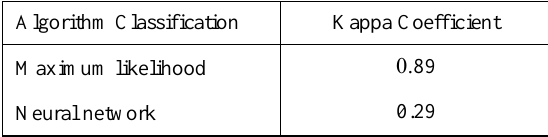
Table 2 . Kappa coefficient for maximum likelihood classification algorithms and neural